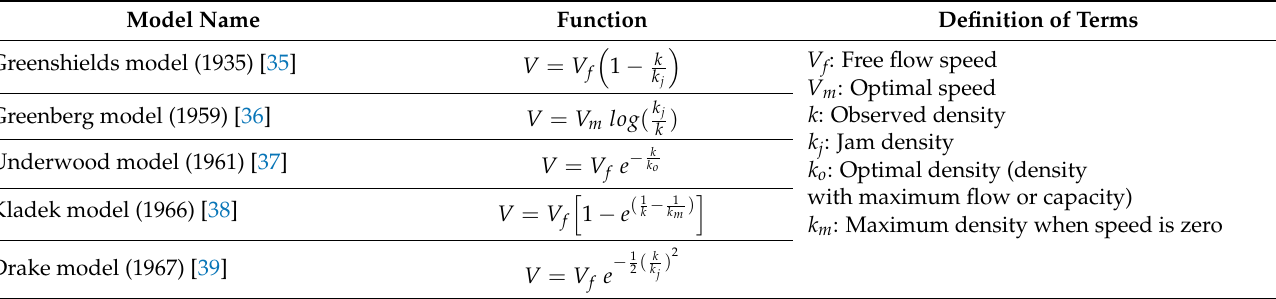
Table 6. Deterministic speed–density models applied in pedestrian